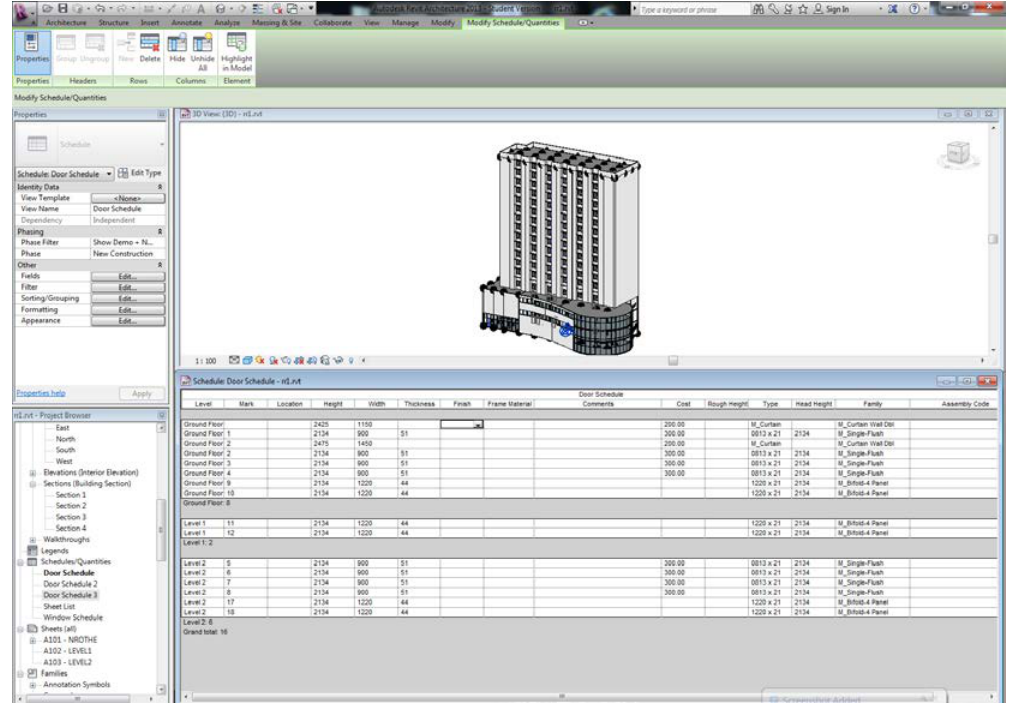
Figure 3: Embedding costs into